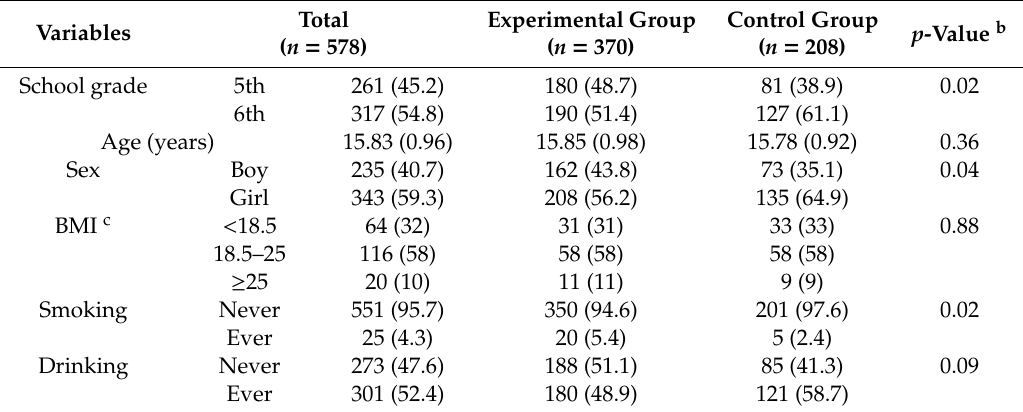
Table 2. Characteristics of study participants